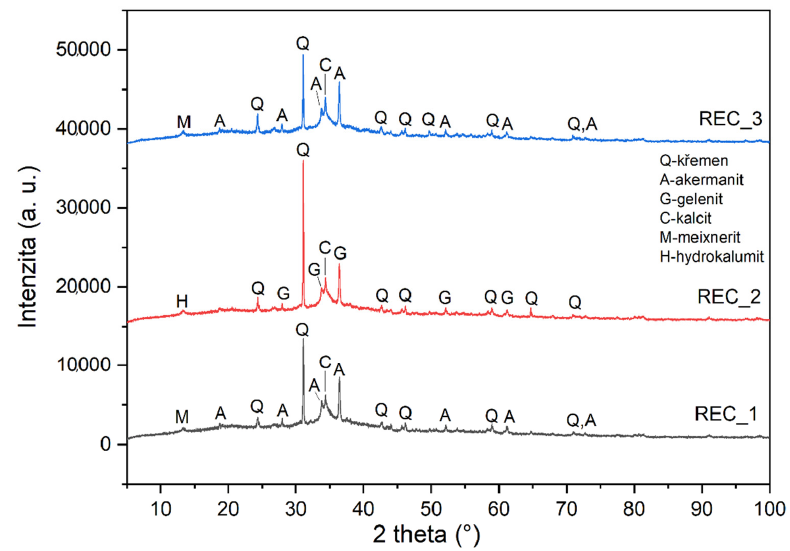
Figure 6. Mineralogical composition determined by X-ray diffraction (XRD) of prepared alkali activated pastes.